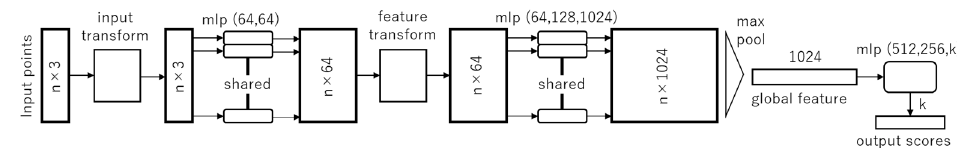
Figure 3. Training model. “mlp:” multilayer perceptron.